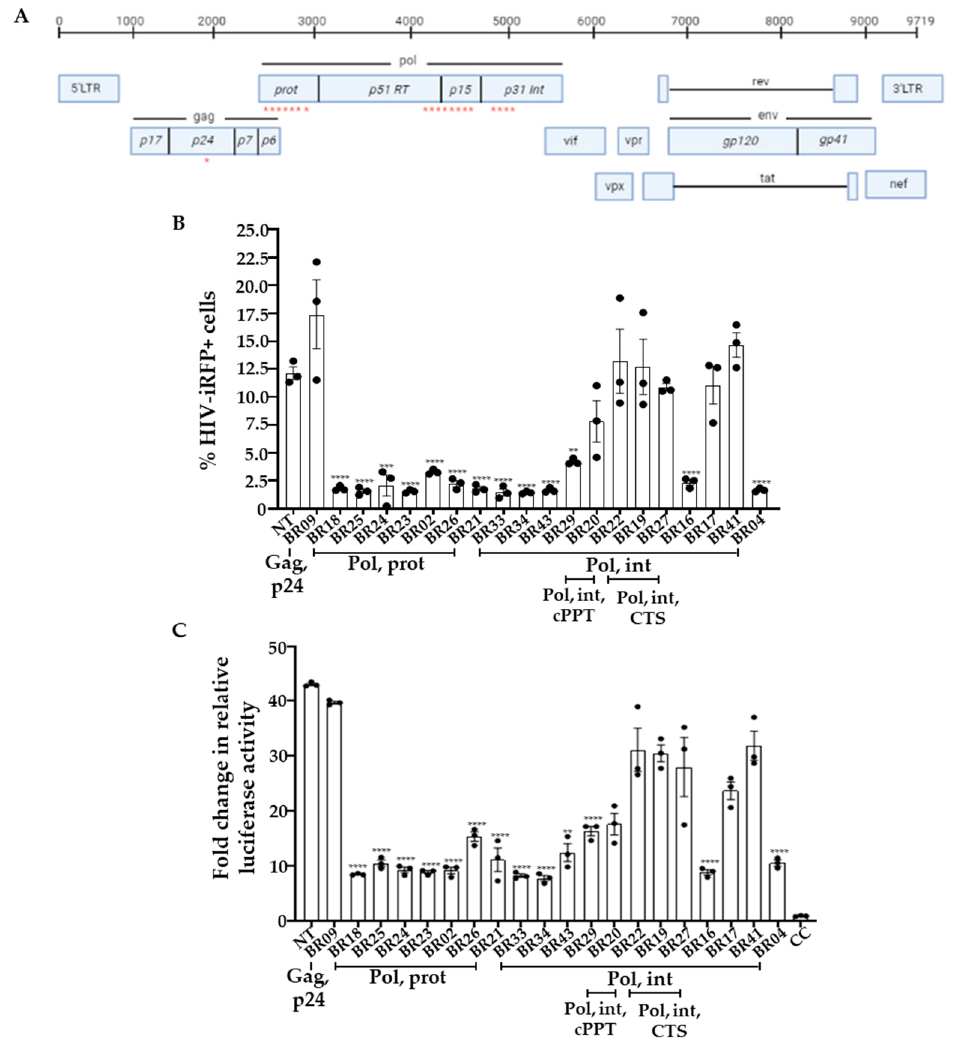
Figure 1. CRISPR/CasRx with HIV-specific single guide RNAs (gRNA) inhibits HIV-1 replication ( A ) schematic representation of HIV genome and gRNA binding sites (red stars; HIV sequence compendium 2018); ( B ) Lenti-XTM cells with stable CasRx-GFP expression (LRx) cells were co-transfected with plasmid encoding gRNA and HIV-encoding iRFP670 fluorescent marker